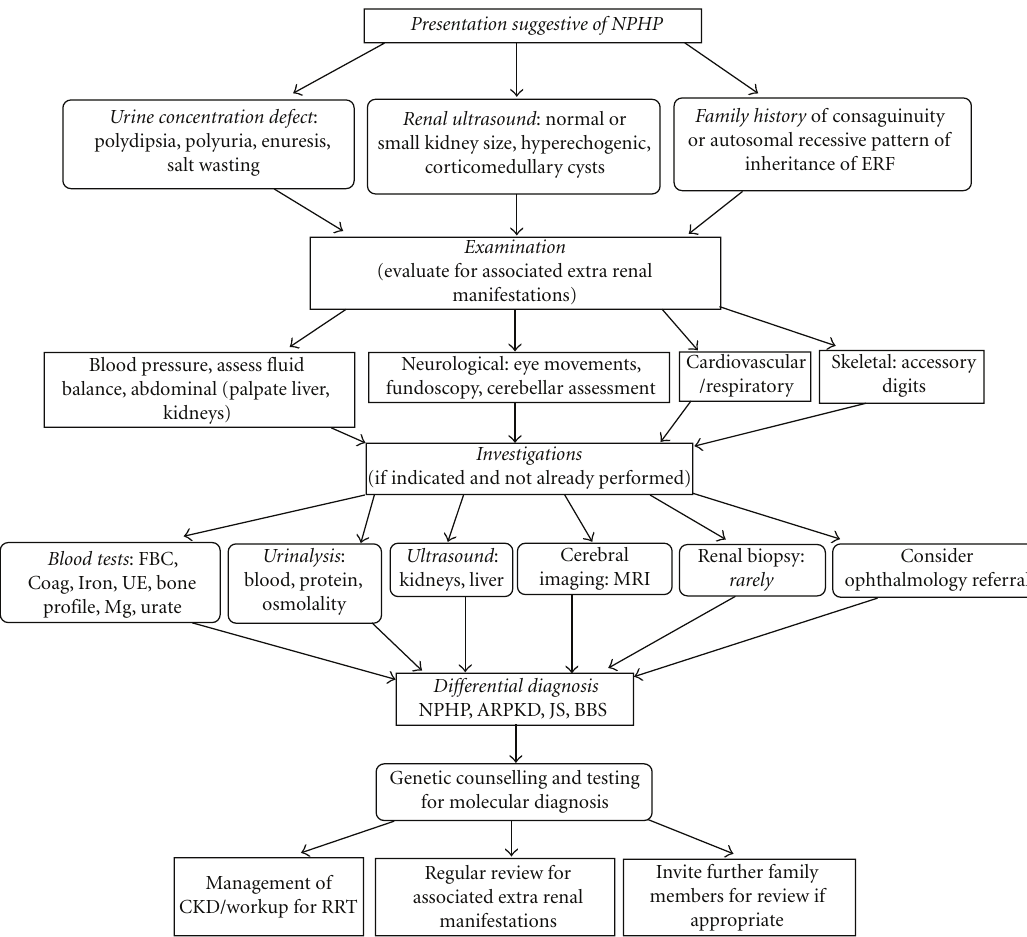
Figure 1: Diagnostic algorithm for suspected cases of NPHP. ARPKD: autosomal recessive polycystic kidney disease; BBS: Bardet-Biedl syndrome; CKD: chronic kidney disease; Coag: coagulation; ERF: established renal failure; FBC: full blood count; JS: Joubert syndrome; LFT: liver function tests; Mg: magnesium; MRI: magnetic resonance imaging; NPHP: nephronophthisis; RRT: renal replacement therapy; UE: urea and